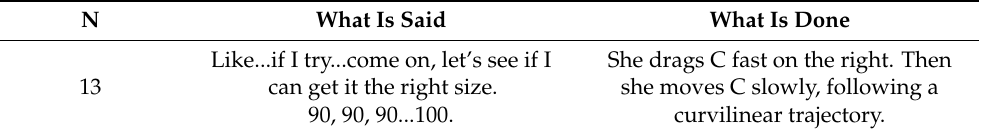
Table 9. Excerpt 5 from Ilaria’s interview.